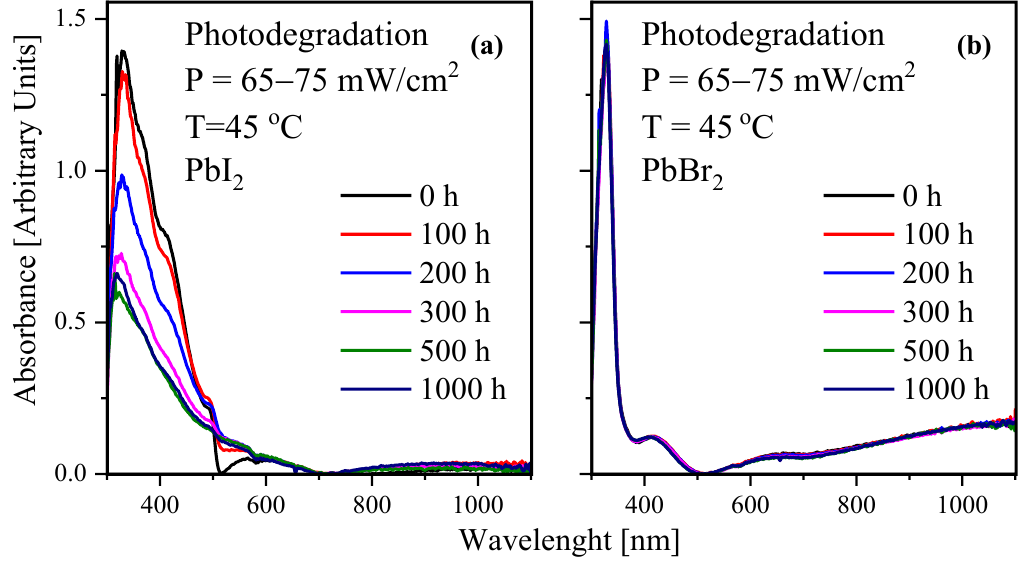
Figure 2. Optical absorbance of light-soaked PbI 2 ( a ) and PbBr 2 ( b ). In Figure 3, the XPS survey spectra of PbI 2 and PbBr 2 halides irradiated with visible light are presented. Table 1 shows the surface composition determined from these spectra.